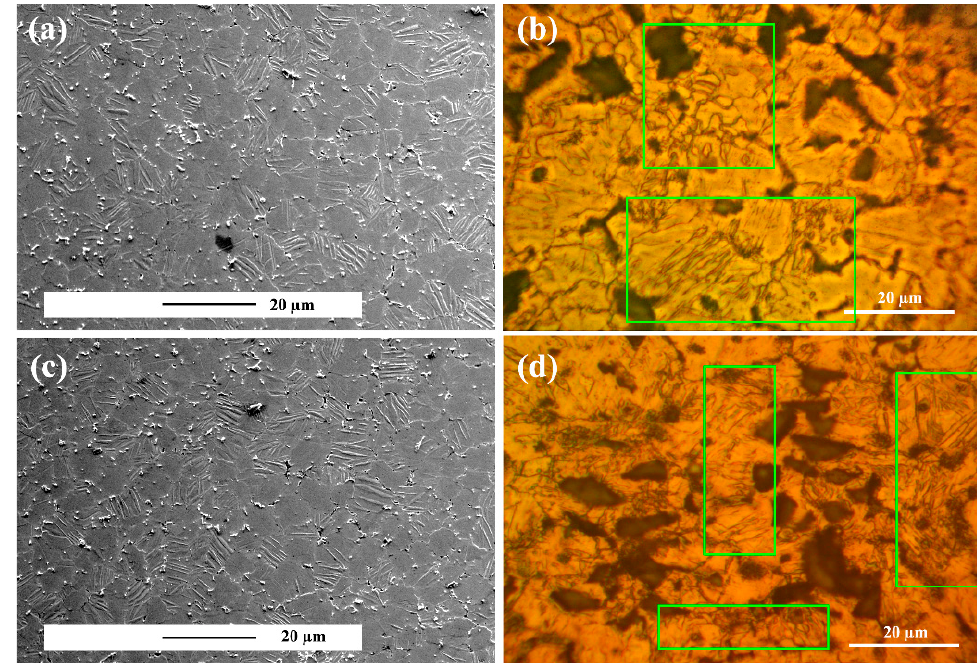
Figure 7. SEM micrographs of the microstructure after 25 h of creep test at 150 °C: ( a ) unreinforced alloy under 30 MPa stress, ( b ) ZK60/SiCp composite under 30 MPa stress, ( c ) unreinforced alloy under 60 MPa stress, and ( d ) ZK60/SiCp composite under 60 MPa stress.